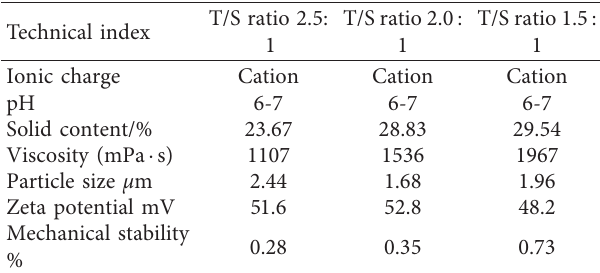
Table 5: Performance specifications of SBS latex.